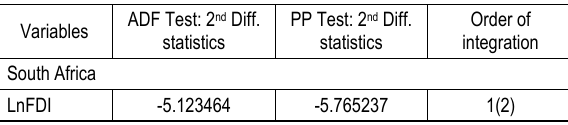
Table 1. Summary of unit root test results